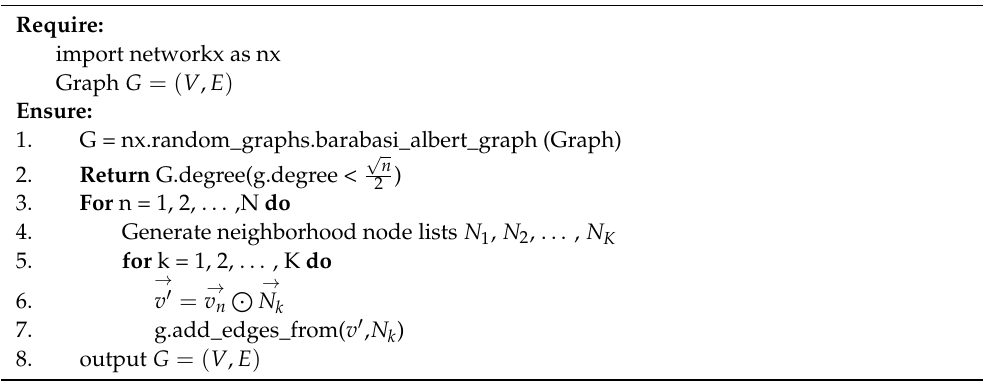
Algorithm 1: Calculate Undirected Node Degree and Neighbor